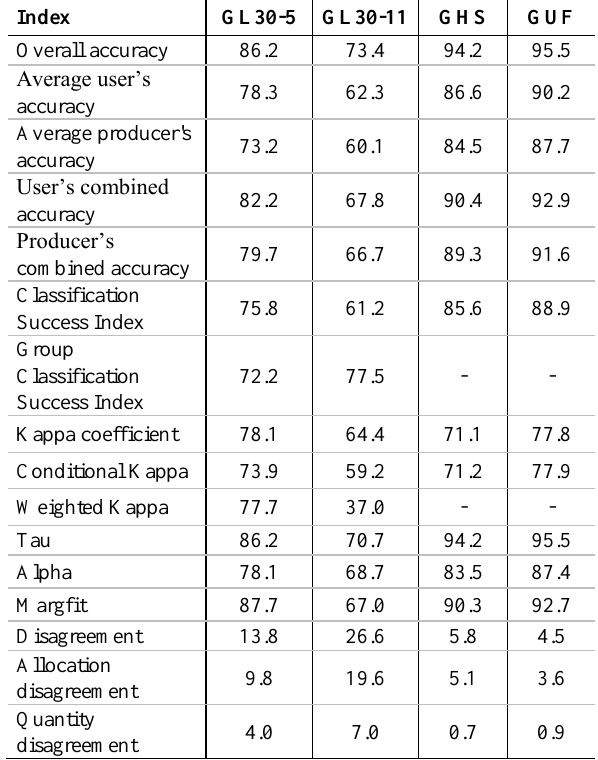
Table 3. Case studies results: global accuracy measures